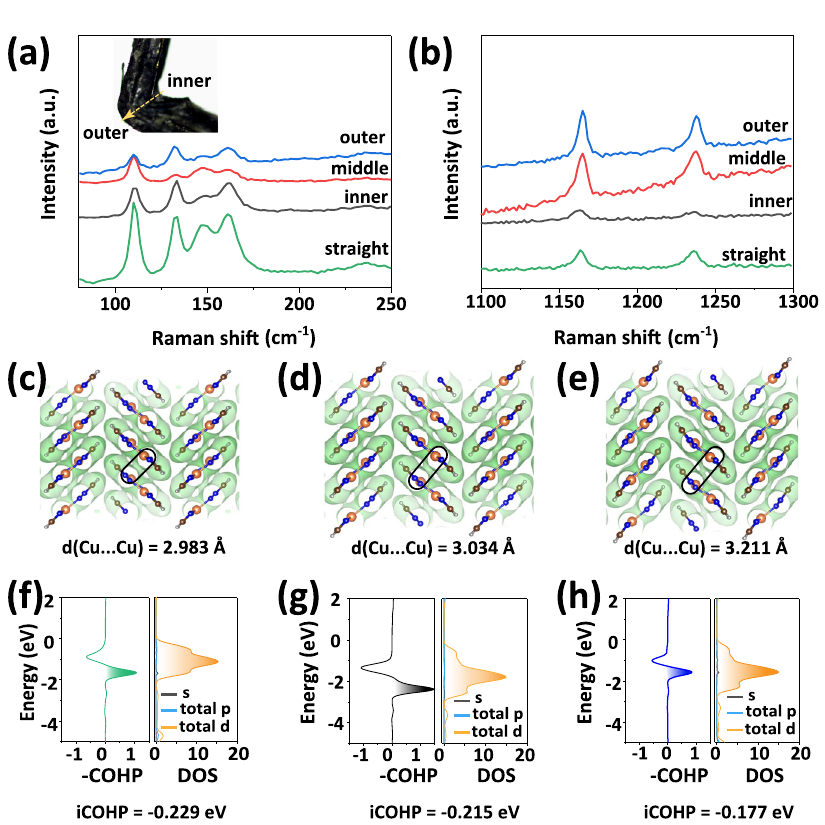
Fig.3|Spatialmicro-Ramanshiftanalysisandtheoreticalcalculations. Thelow- ( a )andhigh-wavenumber( b )Ramanspectrawerecollectedfromtheinner,middle, and outer regions of the bent and the straight section, respectively. The electron